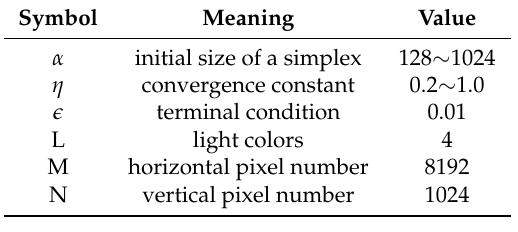
Table 2. Parameters of simplex search methods.